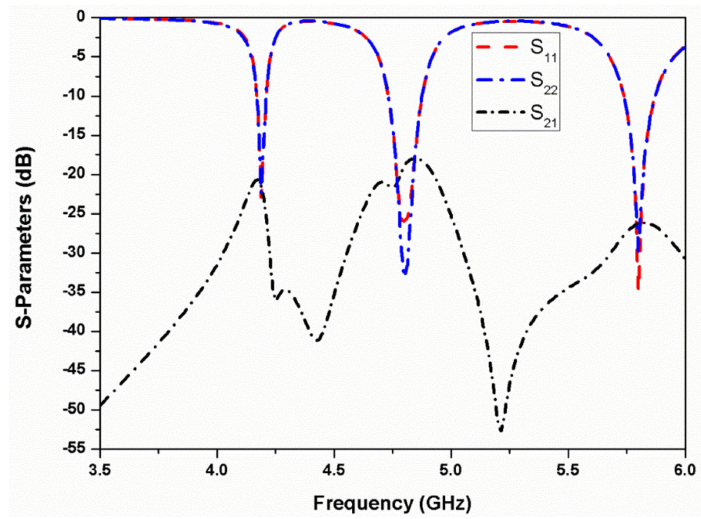
Figure 6. Simulated S-parameters of the two-element stacked MIMO antenna.